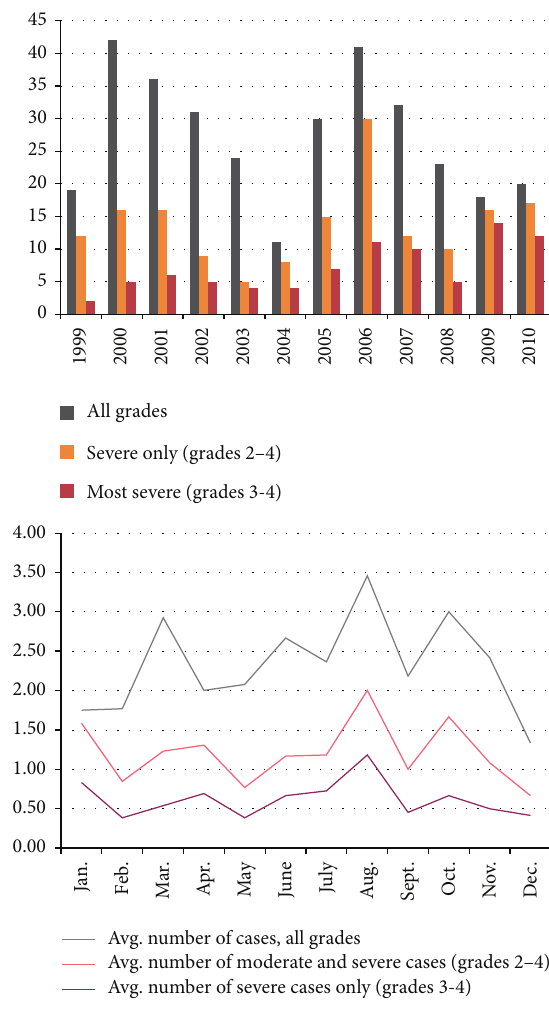
Figure3:NumberofAKcasesdiagnosedbyCFMfrom1999to2010, annual and monthly average, denoted by grade